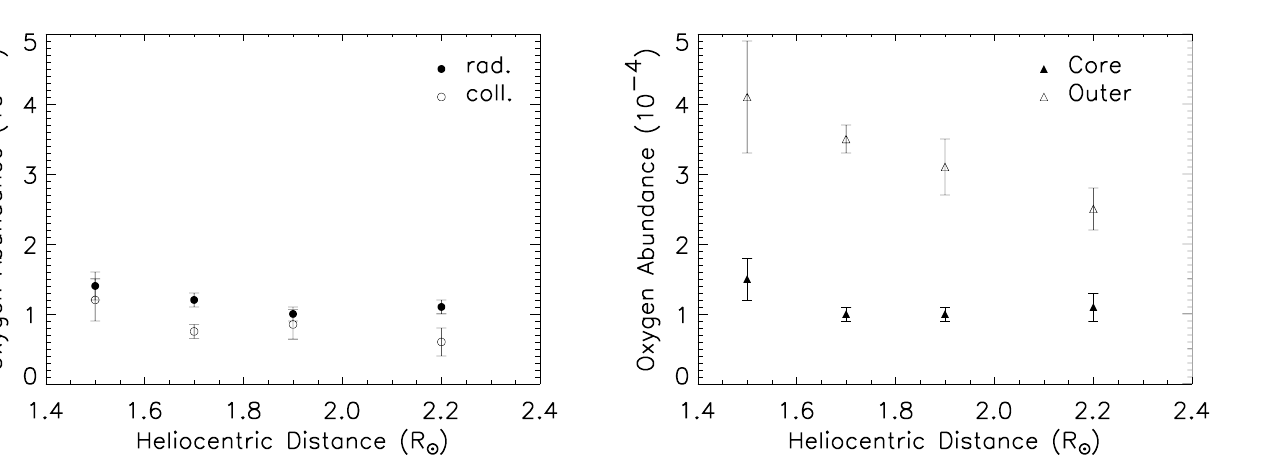
Fig. 4. Average oxygen abundance relative to hydrogen as a func- tion of heliodistance in the streamer core. Full dots and open circles indicate the values derived from the radiative and collisional com- ponents of the O VI 1032 and the H I Ly β lines, respectively.